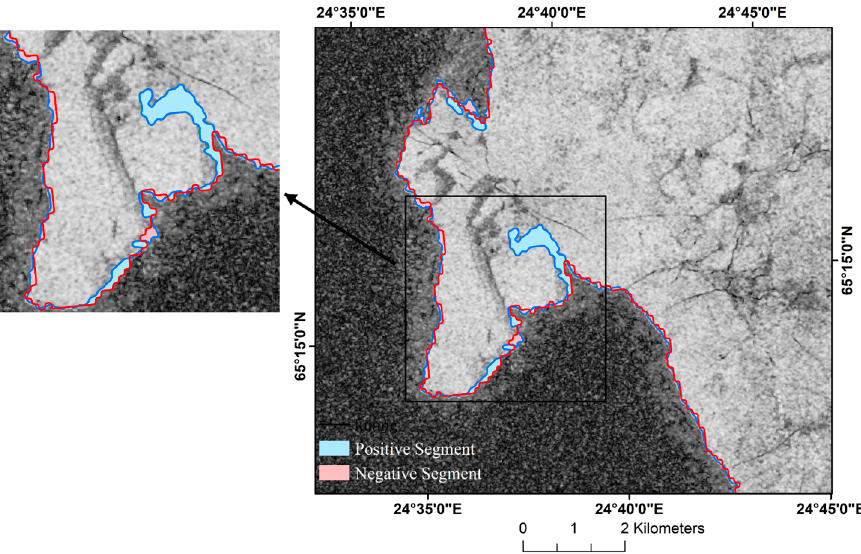
Figure 10. Differences in landfast ice area between the two methods. The negative segments (in red) correspond to a relative underestimation by reference method. The positive segments (in blue) show relative underestimation by the modified approach.